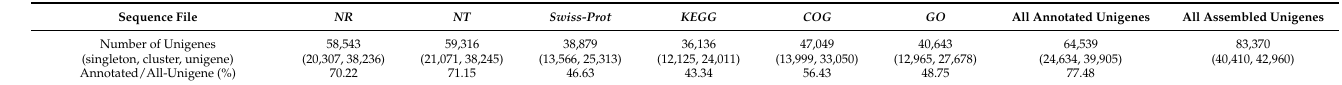
Table 3. Summary of the annotated and assembled sequences of P. chinensis .